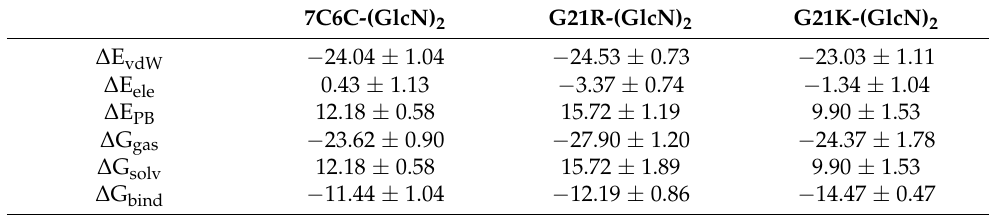
Table 2. Results of MM-PBSA.